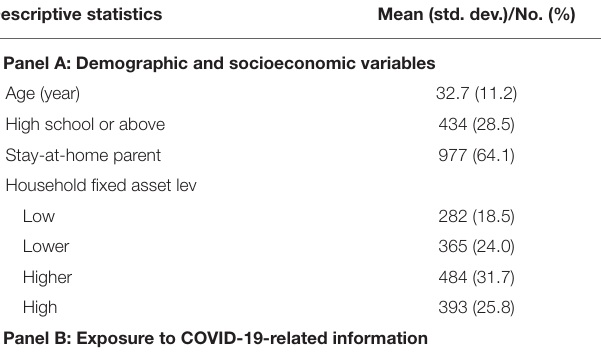
TABLE 1 | Descriptive statistics of women in rural western China ( N =